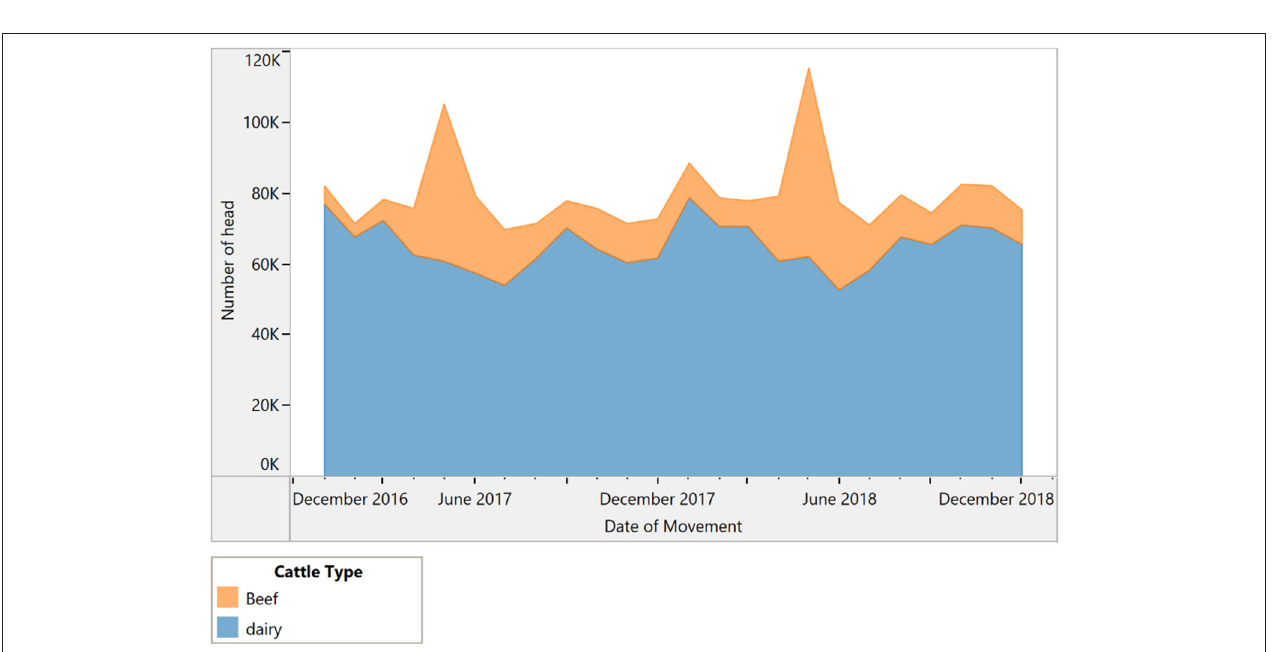
FIGURE 4 | Cows (number of head) moving from California grazing lands (beef) and dairies or feedyards (dairy) from January 2017 to December 2018, includes beef cows moved to grass out of state.